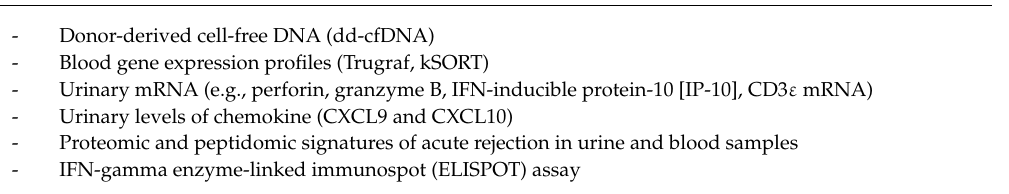
Table 1. Non-Invasive Diagnosis and Prognostication of Acute Allograft Rejection Kidney Transplant